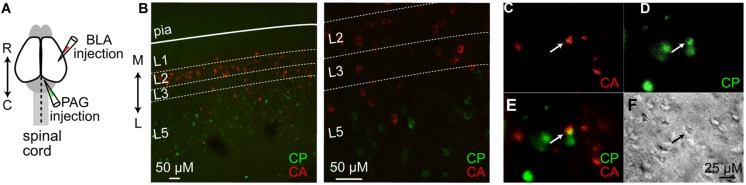
Identifying double-labeled CP/CA neurons in IL. (A) Schematic depicting the concurrent injection of spectrally distinct retrograde fluorescent tracers into the BLA and PAG. (B) Confocal images at 10x and 25x magnification of retrogradely labeled CP (green) and CA (red) neurons in the IL cortex in a 50 μm coronal slice. Epifluorescent images at 60x magnification showing fluorescently labeled (C) CA neurons, (D) CP neurons, and the corresponding (E) overlay and (F) bright-field image. Arrows in each image identify the double-labeled CP/CA neuron. Rostral-caudal: R↔C; lateral-medial: L↔M.